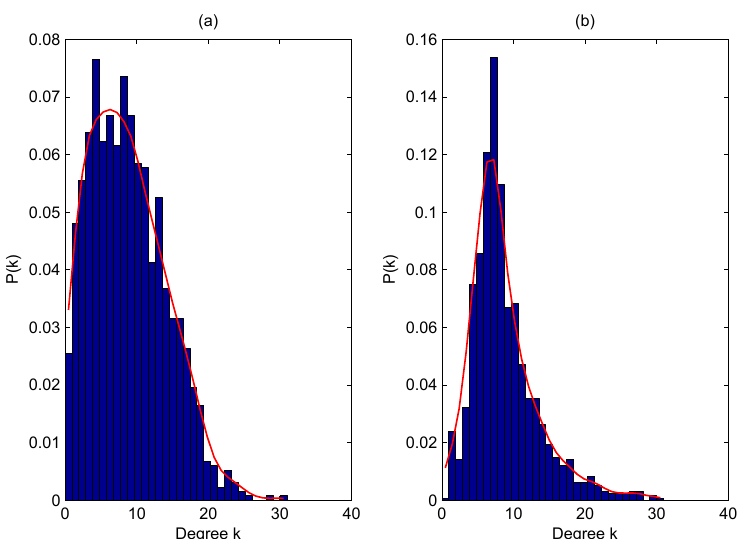
Figure 2. The degree distributions of the ionospheric network. Panel (a) shows the out-degree distribution; panel (b) shows the in-degree distribution. The red curves delineate the distribution